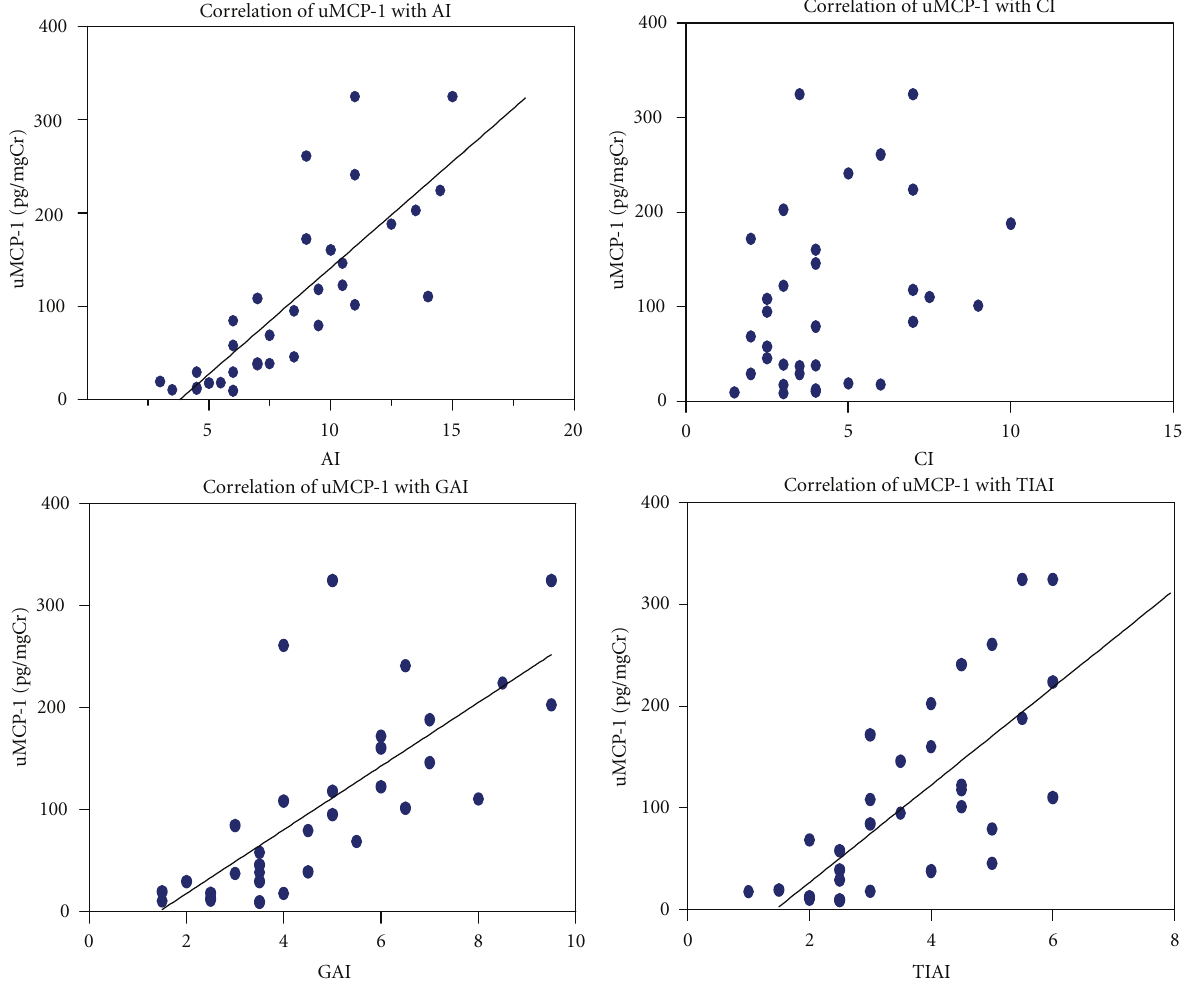
Figure 4: uMCP-1 levels correlated with LN renal biopsy index. A positive correlation ( r = 0 . 800, P < 0 . 01) between Active Index (AI) and uMCP-1 levels had been found from data of 34 patients with LN who had routine renal biopsies. And the analysis of urinary TWEAK levels with Glomerular Activity Index (GAI) and those with Tubulointerstitial Activity Index (TIAI) both yield positive ( r GAI = 0 . 804, r = 0 . 769), significant ( P < 0 . 01) TIAI